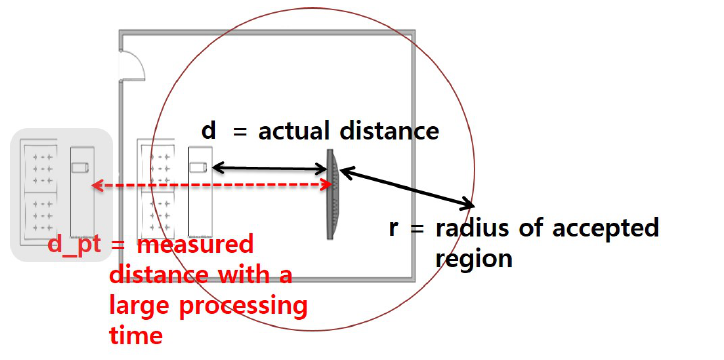
Figure 6. False alarm due to a large processing time.